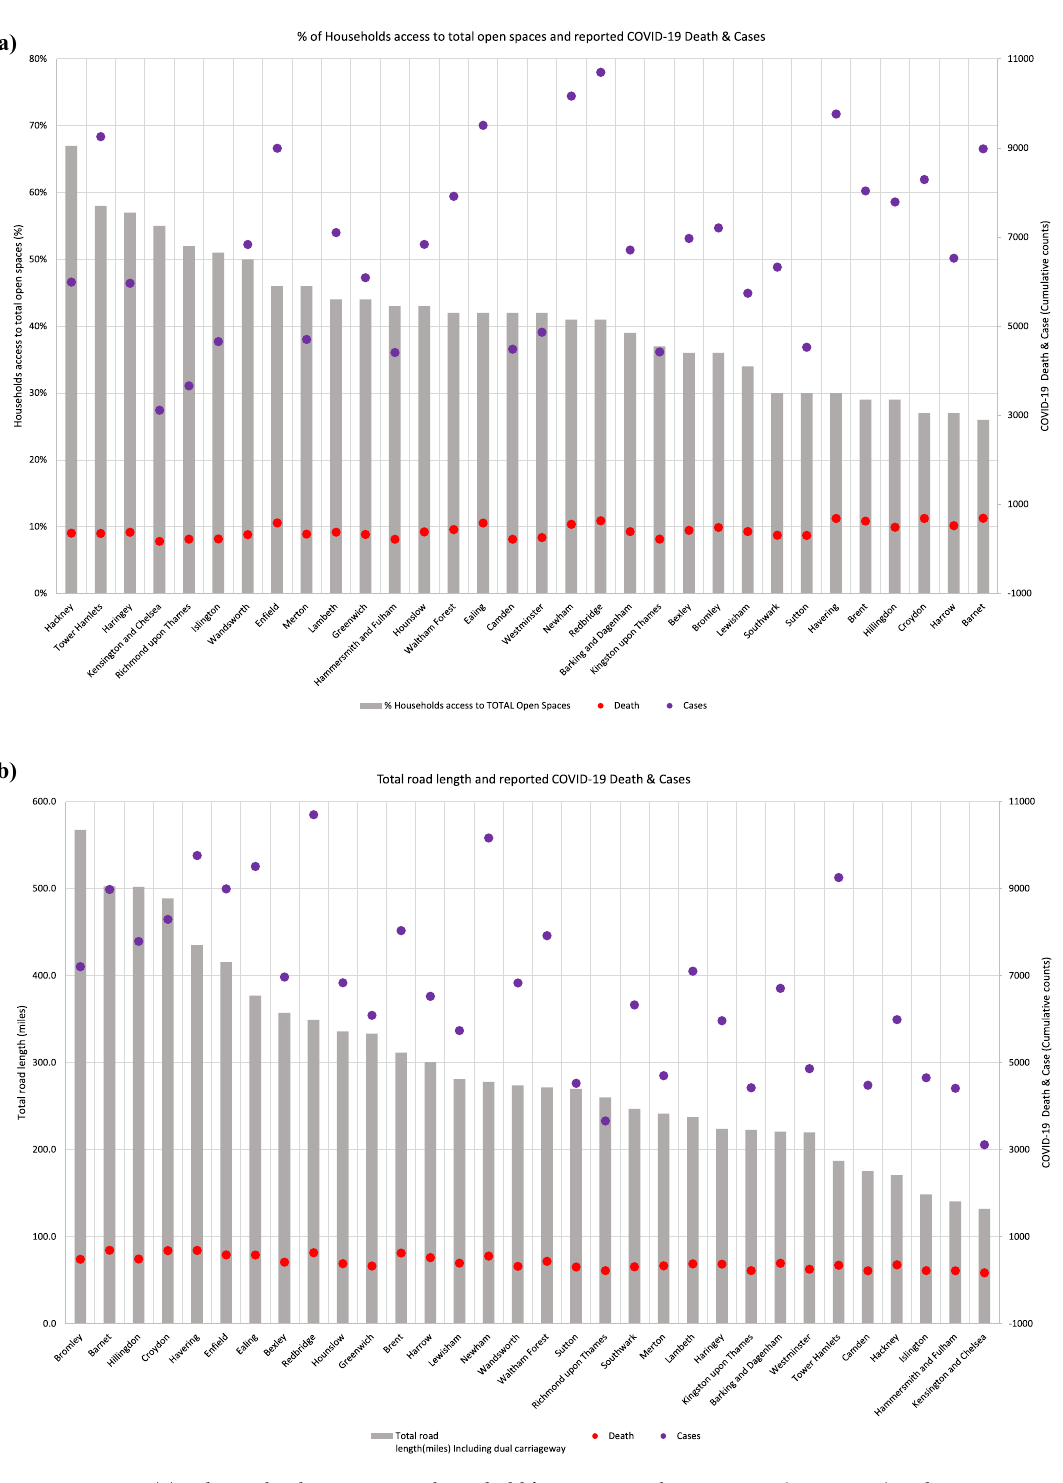
Figure 4. ( a ) Relationship between mean households’ access to total open spaces (percentage) and COVID-19 case and death rate in each London borough. ( b ) Relationship between total road length (miles) and COVID-19 case and death rate in each London